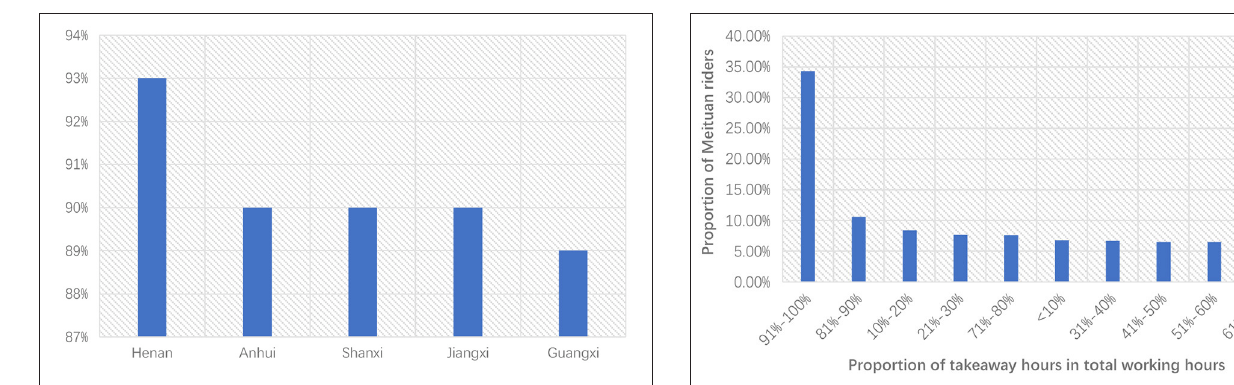
FIGURE 7 | The proportion of working hours on food delivery of Meituan